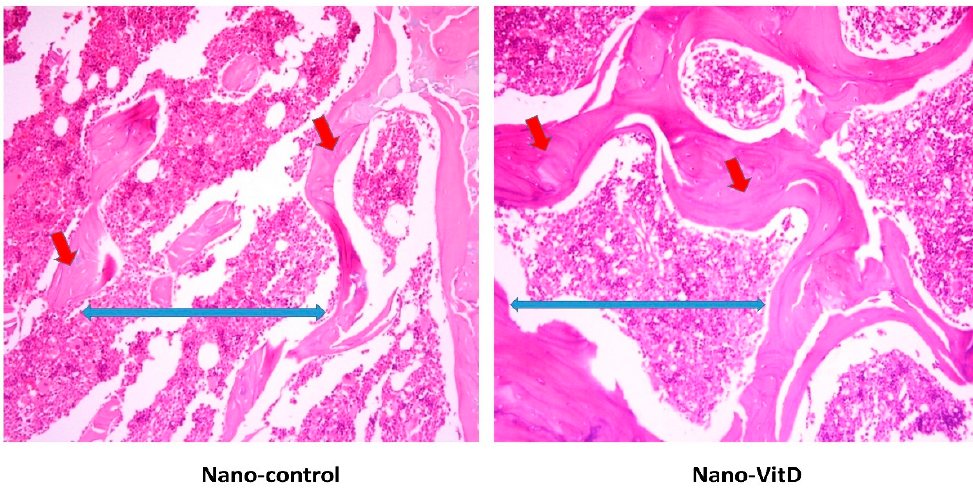
Figure 3. Histopathological changes in femur of rats receiving Nano-VitD vs. Nano-control after one week of treatment. Red arrows are plotting the osteoid area and the blue ones referring to the trabecular separation.